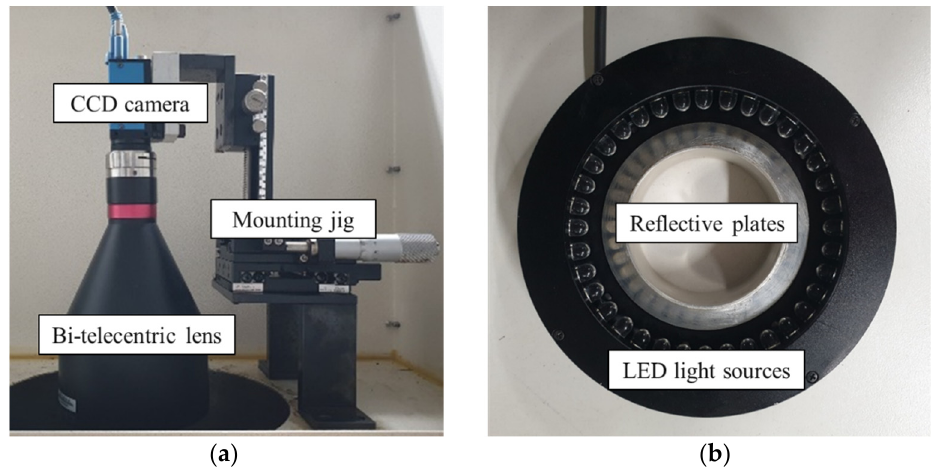
Figure 5. Experimental tools for vision analysis system: ( a ) vision camera with lens; ( b ) light sources and reflective plates.